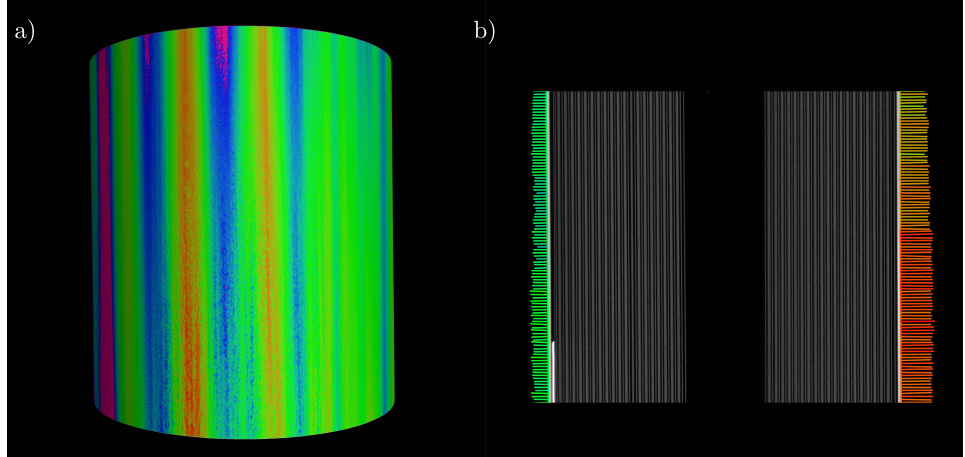
Figure 9. ( a ) 3D representation of the recorded battery volume analyzed for expansion; ( b ) longitudinal section through the battery cell over the recorded height with the corresponding expansion